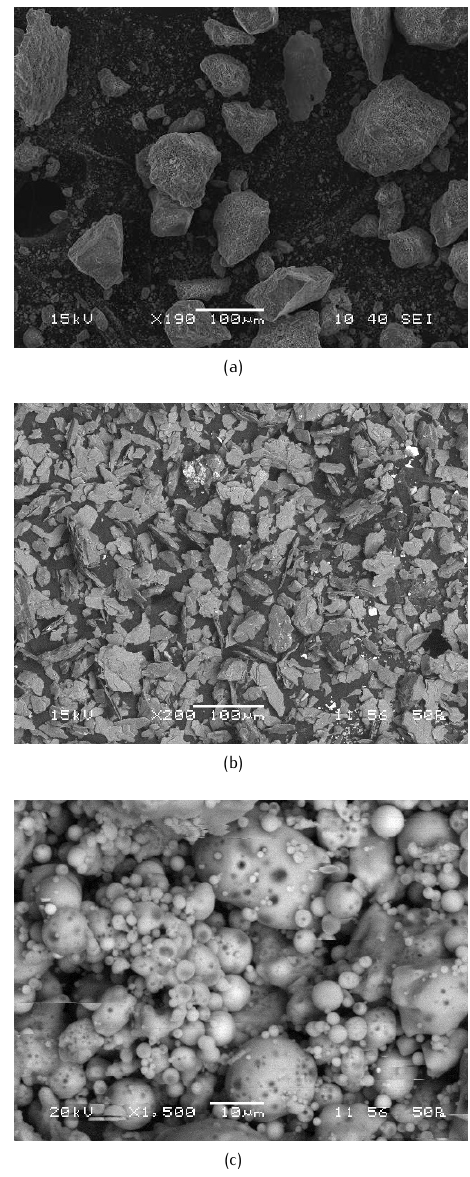
Figure 2. X-ray diffraction pattern of red mud Figure 3. SEM analysis of (a) red mud, (b) local soil and (c) fly